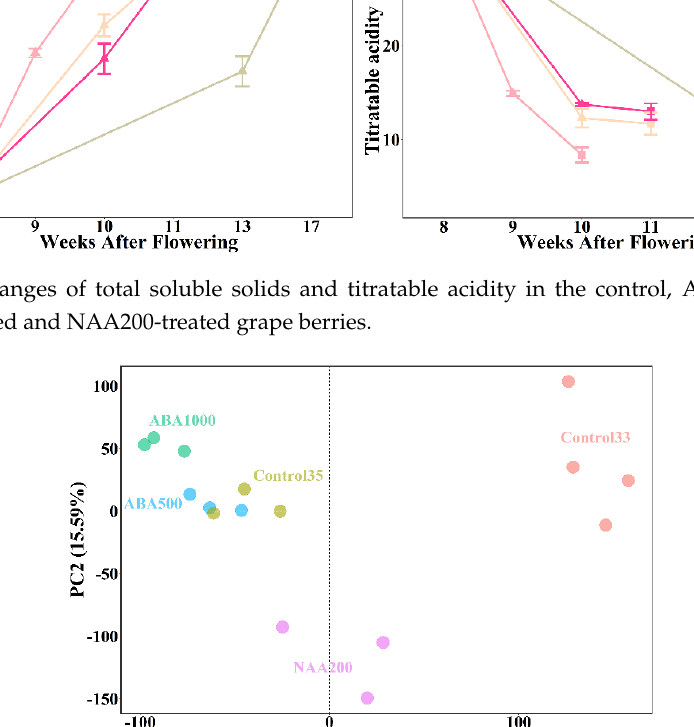
Figure 1. Changes of total soluble solids and titratable acidity in the control, ABA1000-treated, ABA500-treated and NAA200-treated grape berries.